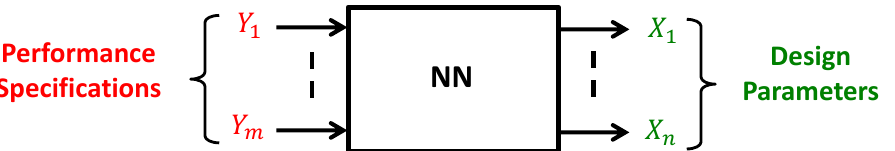
Figure 4. Inputs/outputs of a neural network using the performance metrics directly as fea- tures